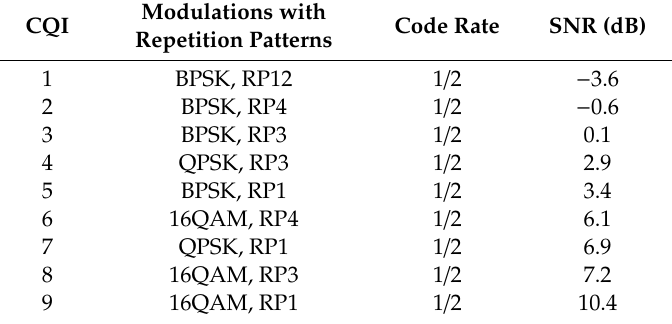
Figure 4. Final MCS (Modulation and Coding Scheme) levels. Table 1. Channel quality indicator (CQI) Table for MCS levels of adaptive modulation in a UAC network system-level simulation